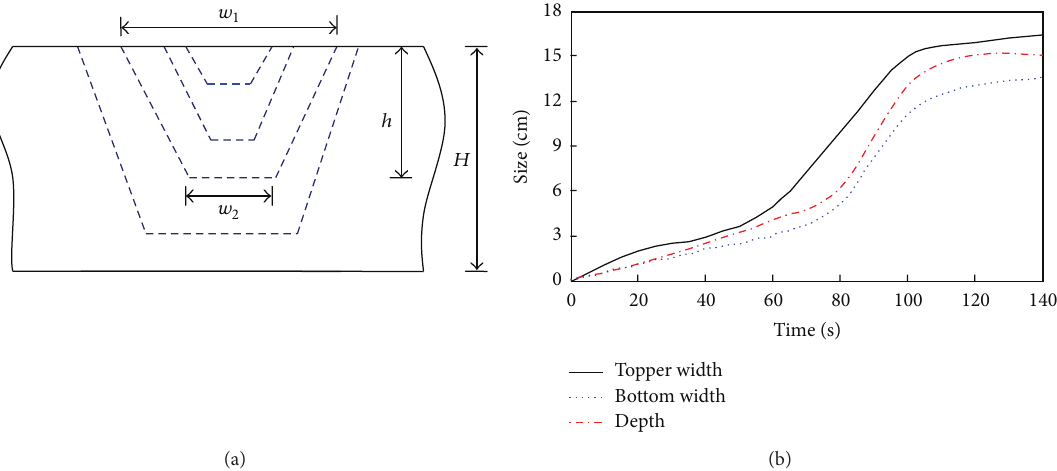
Figure 13: Evolution of the dyke breach when the top length of the dam is 13cm: (a) schematic diagram and (b) evolution of the size of the dyke breach.